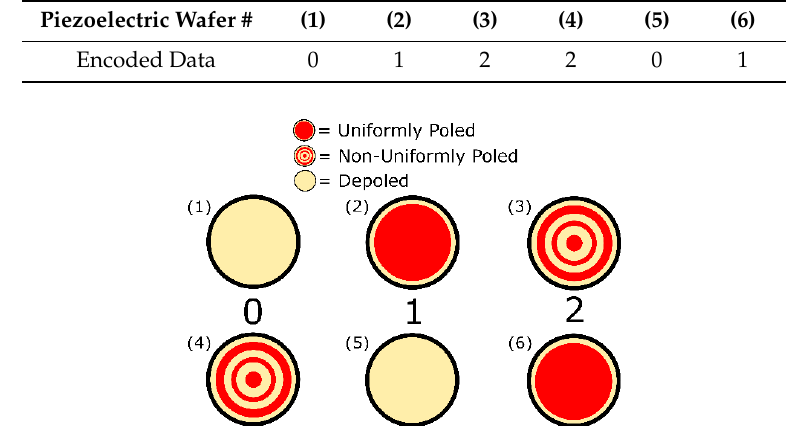
Figure 3. Polarization and arrangement of the piezoelectric circular wafers. The first row reads in ternary encoding as ‘0 1 2,’ and the second row reads as ‘2 0 1.’ The wafers in the 2-by-3 array are numbered in the upper left corner to relate this schematic to the measured conductance spectra shown in Figure 5 and the results in Table 2.